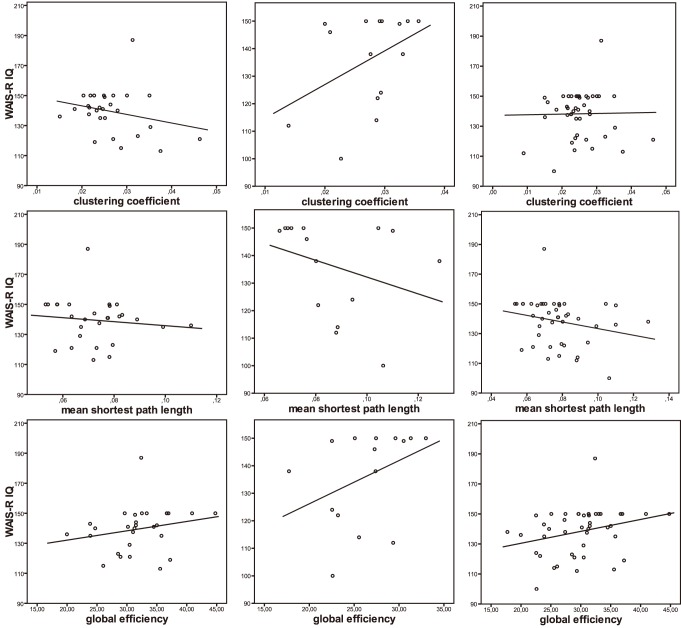
Results of partial correlation analyses investigating the association of network measures and intelligence scores.Left column: younger elderly (<75yrs). Middle column: advanced elderly (≥75yrs). Right column: total sample. Correlations for the advanced elderly were significant. Abbreviations: WAIS-R IQ, revised Wechsler Adult Intelligence Scale intelligence scores.